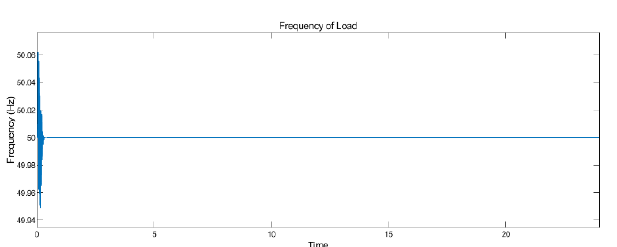
Fig. 22. Zoom image showing the comparison of SMC with all GA optimized